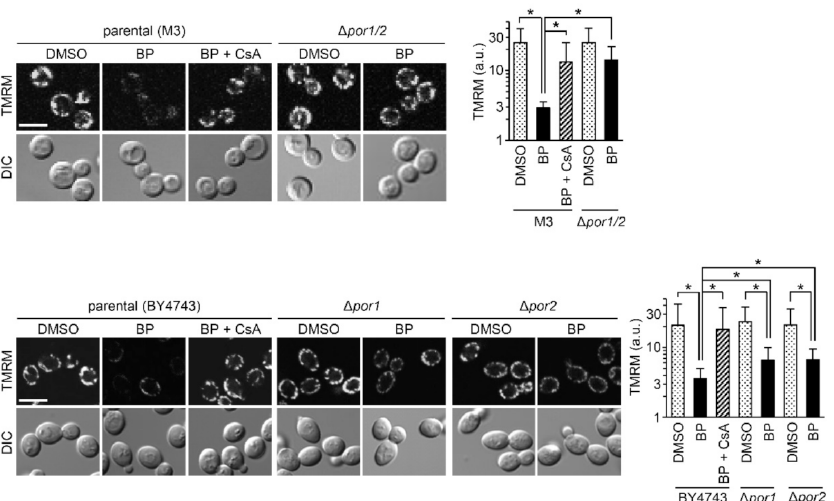
Figure 2. The effect of BP on the mitochondrial membrane potential in a mutant strain with double deficiency ( ∆ por1 / 2 ) and its parental strain (M3), and mutant strains lacking each of porin 1 ( ∆ por1 ) or porin 2 ( ∆ por2 ) and their parent strain (BY4743). Confocal images for TMRM fluorescence at 4 h (left panels) and their data, which represent the mean ± SD from 100–150 cells (* p < 0.001 in upper panel, * p < 0.005 in lower panel). Note the resistance of porin 1, porin 2, and porin/1/2 mutants to BP-induced depolarization. Scale Bars: 5 µ